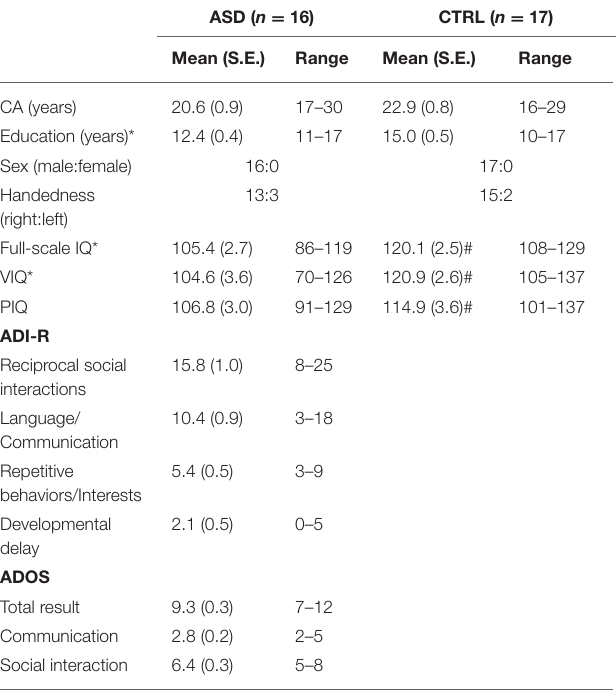
TABLE 1 | Demographic and diagnostic